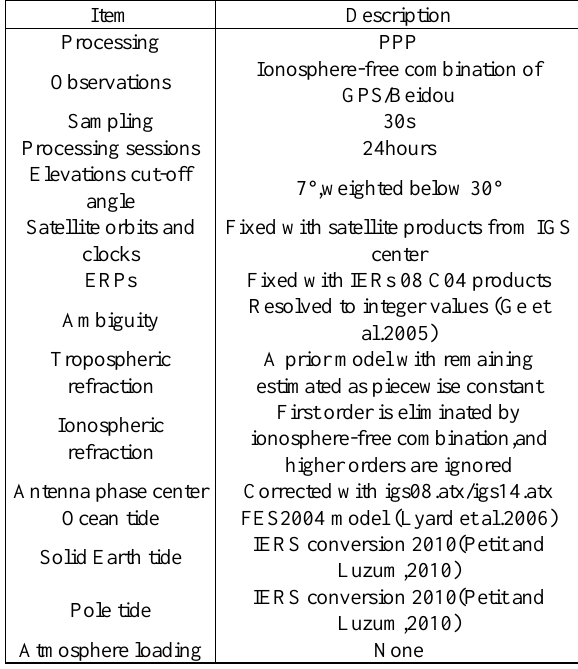
Table 2 . PPP calculation strategies